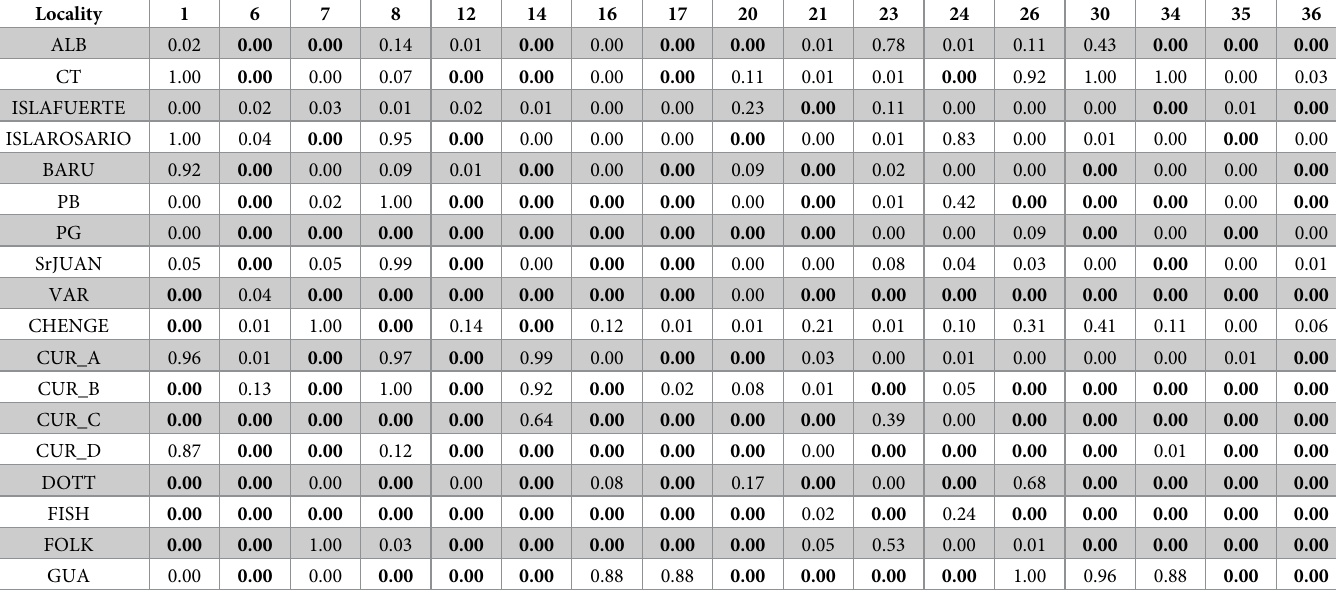
Table 4. P- values to test deviation from Hardy Weinberg Equilibrium for each population and locus. Significant (p < 0.001) values are presented in bold.